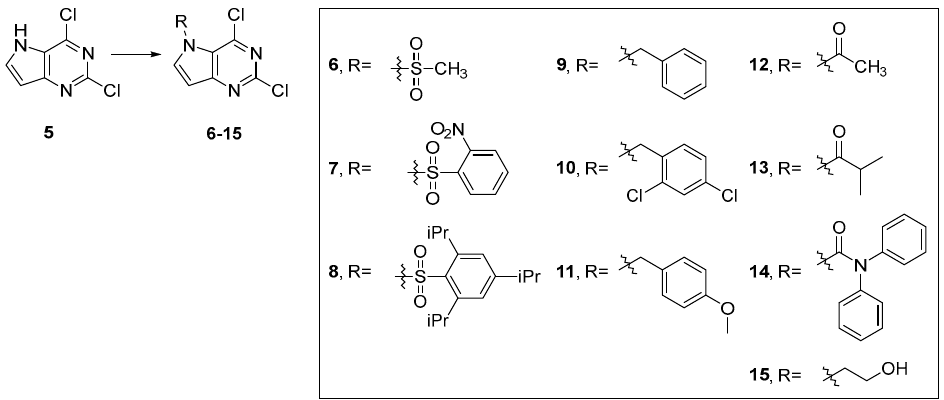
Figure 3. Target compounds, starting from parent compound 5 . Compounds 6 – 15 were submitted to the National Cancer Institute for NCI-60 cell line screening.